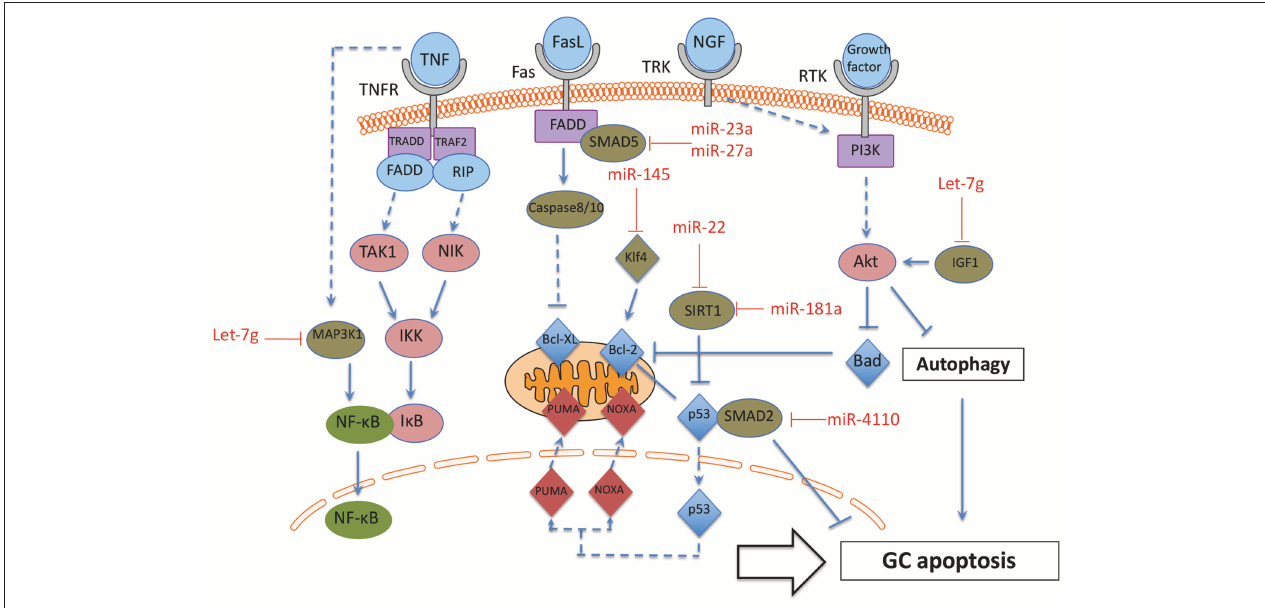
FIGURE 4 | The interaction between miRNAs and apoptosis pathway in GC. These miRNA-mRNA communications could greatly modulate GC apoptosis during the process of follicle atresia. MAP3K1, Mitogen-activated protein kinase 1; Klf4, Kruppel-like factor 4; SMAD2, SMAD family member 2; SMAD5, SMAD family member 5; SIRT1, NAD-dependent deacetylase sirtuin-1; IGF1, insulin like growth factor 1. Arrowhead line, promotion; Flat-end line,